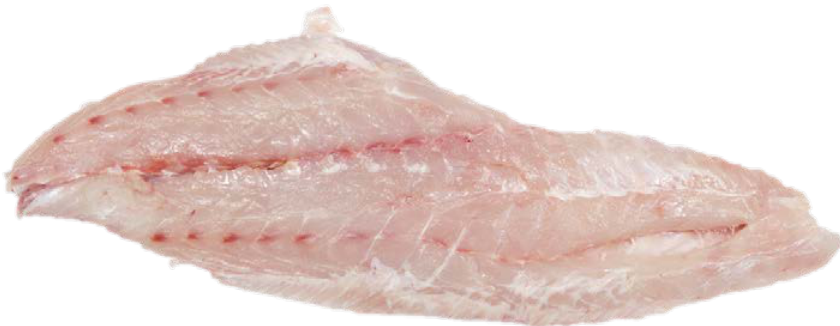
Figure 2. Fresh fish fillet. (Source: Florida Sea Grant).